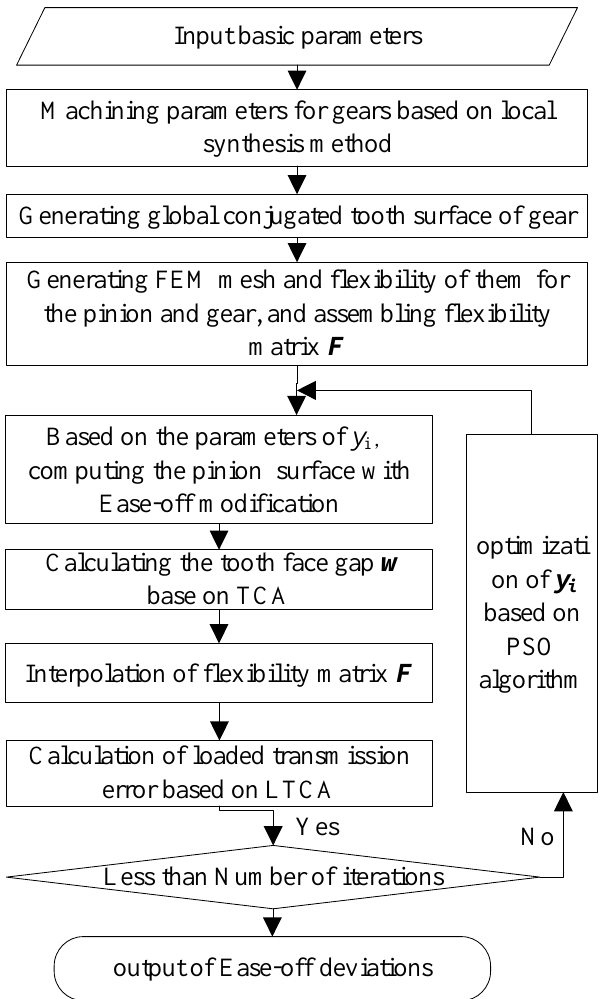
Figure 3. The Flowchart of the Ease-off modified optimization.